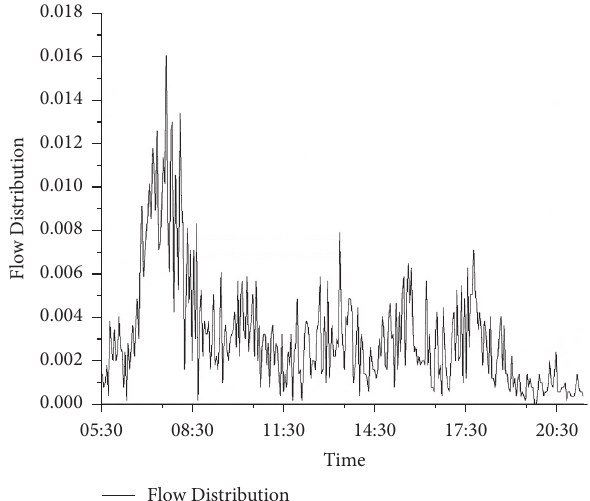
Figure 3: Distribution of card swiping frequency of uplink passengers.